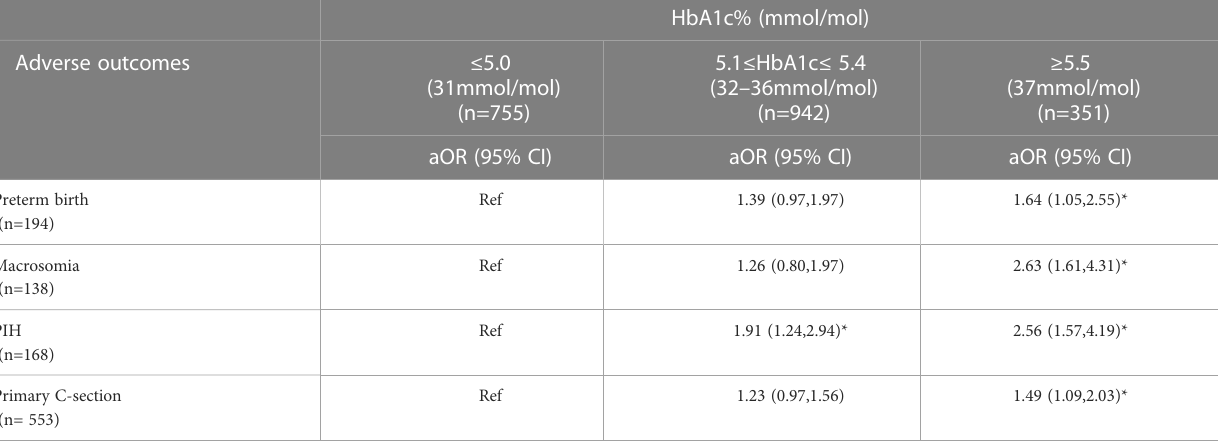
TABLE 2 Association between HbA1c and adverse outcomes.